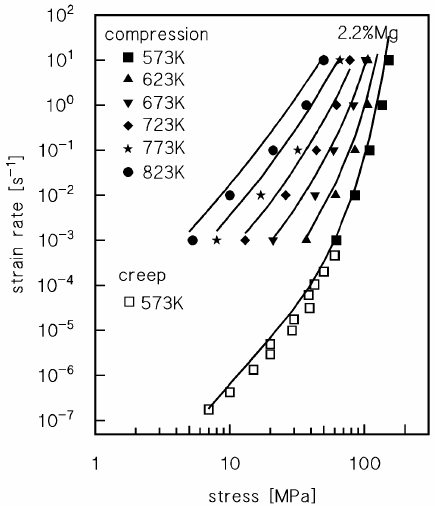
Figure 10. Compression data for 2.2%Mg [28] and creep data from [1,29]. The curves were calculated as in Figure 9.